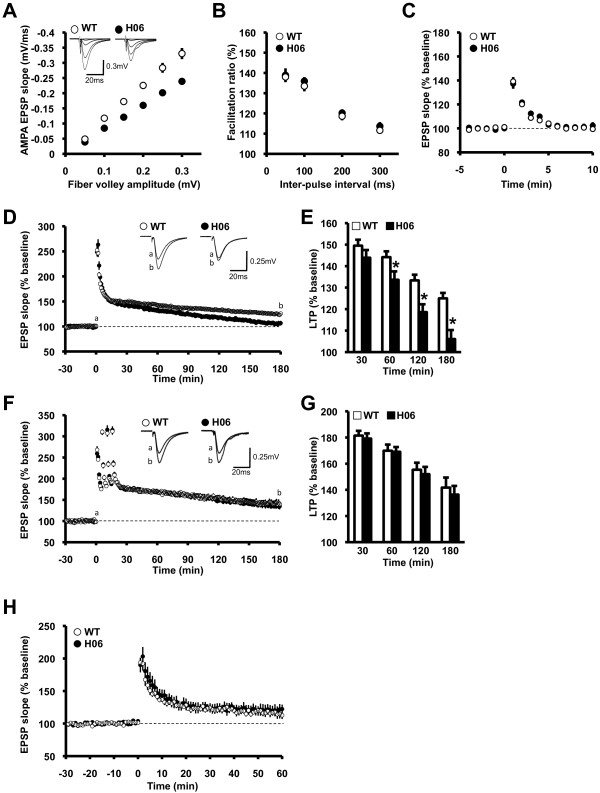
Basal synaptic transmission and LTP in the hippocampus of dnRAR mice. (A) The input-output relationships of AMPA receptor-mediated EPSP in WT (n = 9) and dnRAR H06 (n = 8) mice. The sample traces in the inset represent the responses evoked with the five different stimulus intensities and the stimulus artifacts were truncated. The data were first sorted by the amplitude range of the fiber volleys, and then the EPSP slopes were averaged within each range. (B) PPF induced by stimulating afferent fibers twice at intervals of 50, 100, 200, and 300 ms in WT (n = 9) and dnRAR H06 (n = 8) mice. (C) PTP induced by high-frequency stimulation (one 100 Hz, 1 s train) in the presence of D-APV (50 μM) in WT (139.2 ± 3.5% of baseline; n = 12) and dnRAR H06 (137.2 ± 4.1% of baseline; n = 10) mice. (D) LTP induced by single conditioning stimulation (one 100 Hz, 1 s train) in WT (n = 30) and dnRAR H06 (n = 16) mice. The initial EPSP slopes were measured, and the values were normalized in each experiment to the averaged slope value measured during the control period (-30 to 0 min). Conditioning stimulation was applied at 0 min. The sample traces in the inset represent the EPSPs (average of 10 consecutive responses) of WT and H06 mice recorded at the times indicated by the letters. The stimulus artifacts were truncated. (E) Summary of LTP induced by single conditioning stimulation in WT and dnRAR H06 mice (21-30 min: WT, 149.5 ± 2.0%; H06, 143.9 ± 3.5%; 51-60 min: WT, 144.1 ± 2.4%; H06, 133.6 ± 3.8%; 111-120 min: WT, 133.3 ± 2.9%; H06, 118.6 ± 3.6%; 171-180 min: WT, 125.0 ± 3.3%; H06, 106.0 ± 4.2% of baseline) (t test, *p < 0.05). (F) LTP induced by strong conditioning stimulation (four 100 Hz, 1 s trains at 5 min intervals) in WT (n = 6) and dnRAR H06 (n = 9) mice. The initial EPSP slopes were measured, and the values were normalized in each experiment to the averaged slope value measured during the control period (-30 to 0 min). Conditioning stimulation was applied at 0 min. The sample traces in the inset represent the EPSPs (average of 10 consecutive responses) of WT and H06 mice recorded at the times indicated by the letters. The stimulus artifacts were truncated. (G) Summary of normalized LTP induced by strong conditioning stimulation in WT and dnRAR H06 mice (21-30 min: WT, 181.4 ± 3.6%; H06, 179.2 ± 3.9%; 51-60 min: WT, 169.9 ± 4.6%; H06, 169.0 ± 3.6%; 111-120 min: WT, 155.3 ± 5.3%; H06, 151.9 ± 5.5%; 171-180 min: WT, 141.7 ± 7.7%; H06, 136.3 ± 6.6% of baseline). (H) STP induced by short conditioning stimulation (one 100 Hz, 100 ms train) in WT (116.2 ± 5.1% of baseline; n = 5) and dnRAR H06 (120.6 ± 8.1% of baseline; n = 5) mice. The initial EPSP slopes were measured, and the values were normalized in each experiment to the averaged slope value measured during the control period (-30 to 0 min). Conditioning stimulation was applied at 0 min. Error bars indicate SEM.